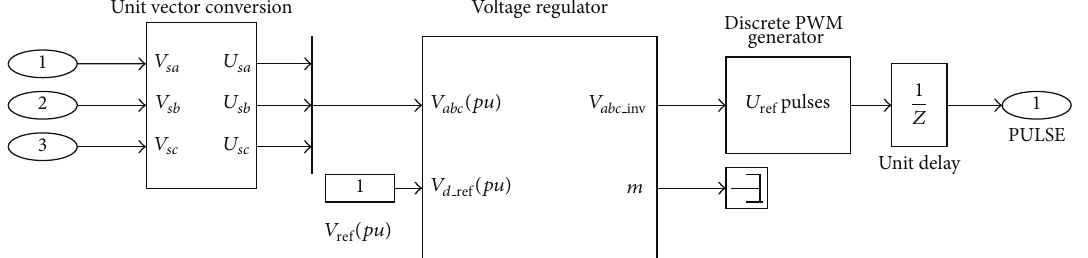
Figure 3: Simulation block diagram for SVPWM to generate gate pulses.